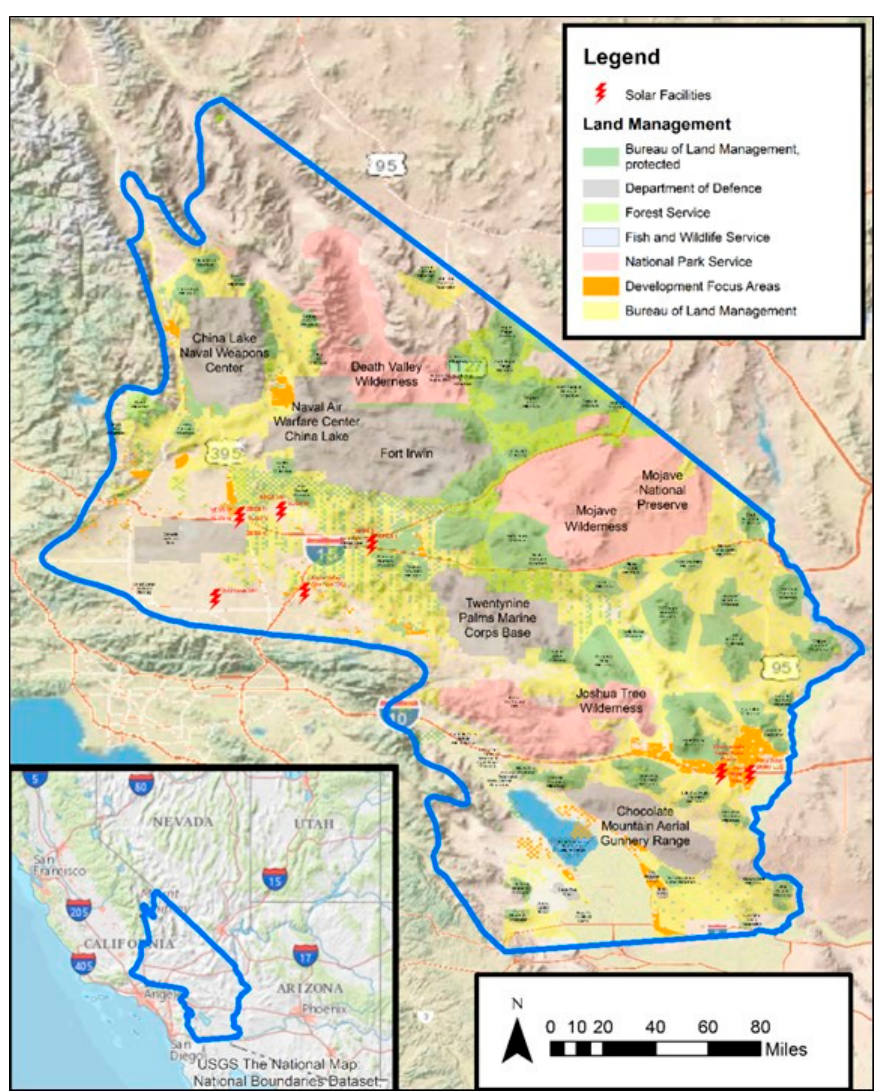
Figure 1. Map of the Desert Renewable Energy Conservation Plan (DRECP) study area in southern California showing boundaries of National Parks, BLM-protected Wilderness Study Areas (WSAs), and Development Focus Areas (DFAs) with solar energy development site names.